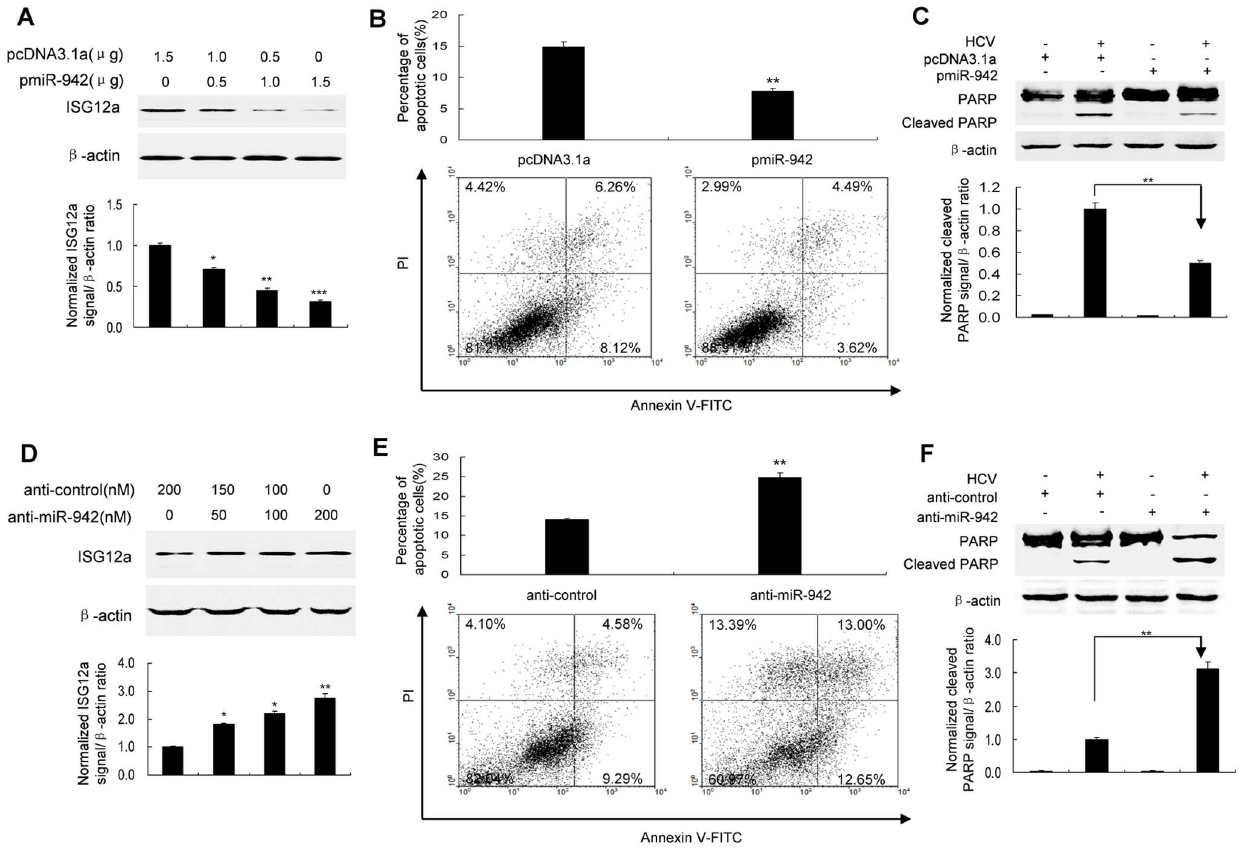
Figure 6. MiR-942 modulates HCV-induced apoptosis of human hepatocytes via targeting ISG12a. ( A ) Forced expression of miR-942 in HCV-infected HLCZ01 cells reduced the level of ISG12a. HLCZ01 cells were transfected with pcDNA3.1-miR-942 (pmiR-942). ISG12a was examined by western blot. b –actin was used as control. ( B/C ) Forced expression of miR-942 in HCV-infected HLCZ01 cells caused a marked decrease in apoptosis induction as determined by flow cytometry and PARP cleavage. HLCZ01 cells were transfected with pcDNA3.1-miR-942 and infected by HCV for